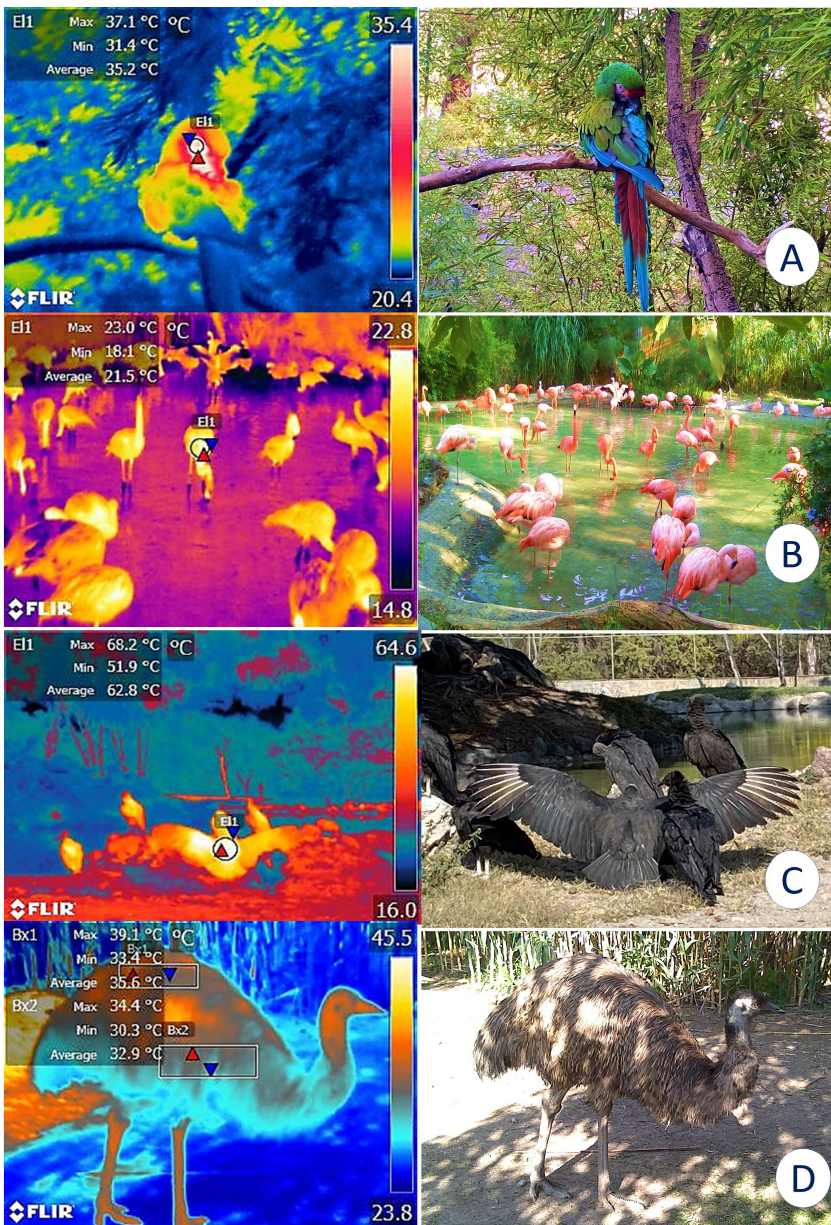
Figure 12. Differences in the thermoregulatory performance of birds with different types of feathers. ( A ). Radiometric image of a military macaw ( Ara militaris ) at rest on a perch. In this species, the ocular window can serve to evaluate thermal responses by detecting average ocular temperatures (El1) (35.2 ◦ C). ( B ). The dorsal region (EL1) of flamingos ( Phoenicopterus ruber ) covered by feathers registered an average value of 21.5 ◦ C despite direct exposition to solar radiation. ( C ). In contrast to the light-colored feathers of the flamingo, the dorsal area (El1) of a black vulture ( Coragyps atratus ) shows an average temperature of 62.8 ◦ C with a maximum value of 68.2 ◦ C. In the digital image of the vulture, a spread-wing posture is observed. This is a thermoregulatory behavior that helps dissipate heat when birds experience temperatures above their thermoneutral range. ( D ). Infrared reading of an emu ( Dromaius novaehollandiae ) where the temperature in the dorsal (Bx1) and ventral regions (Bx2) can be compared, observing an average difference of 6.2 ◦ C. This difference may be attributable to the presence of long feathers that aid in dissipating heat. (Radiometric images and photographs by the authors). Maximum temperature (red triangle), and minimum (blue triangle). Thermal images obtained using a FLIR thermal